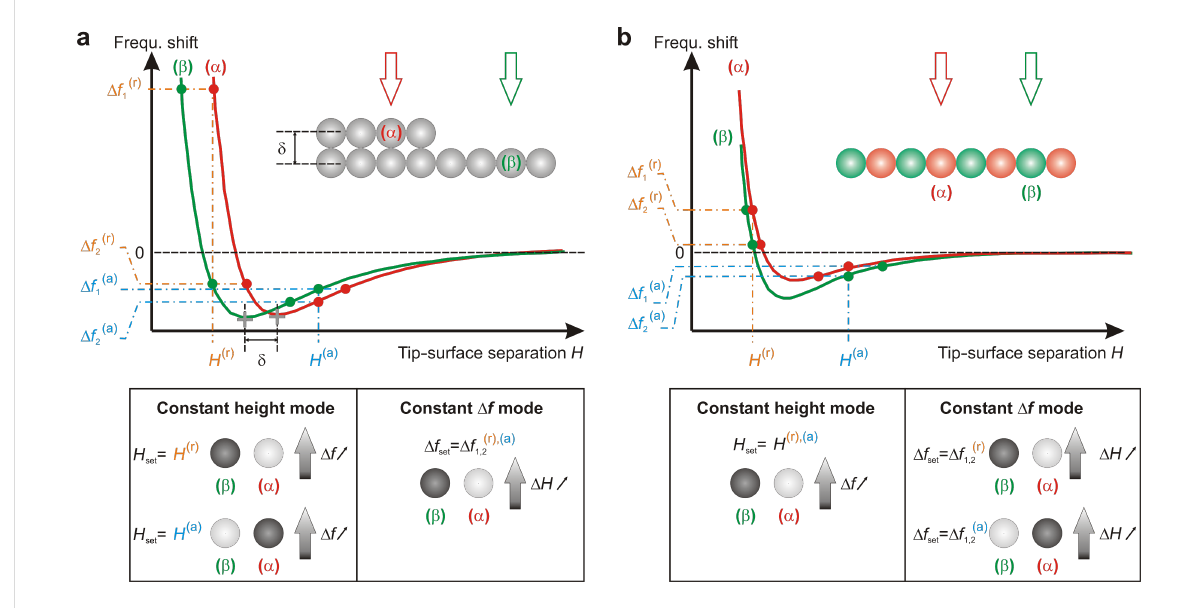
Figure 1: Illustration of constant-height and constant- Δ f imaging modes in nc-AFM. We consider, as an illustrative situation, the cases of a homoge- neous and atomically corrugated surface with a step (a) and a heterogeneous, but still atomically corrugated surface (b). In each situation frequency shift versus tip–surface separation ( H ) curves are presented above α and β surface sites. The tables below the curves illustrate the resulting imaging contrast (from white to dark grey, standing for large to small values of the variable) above each type of site depending upon the imaging mode. Contrast-inversion situations may appear depending on (i) the imaging mode, (ii) the interaction regime between the tip and the surface and (iii) the nature of the interaction between the tip and the surface